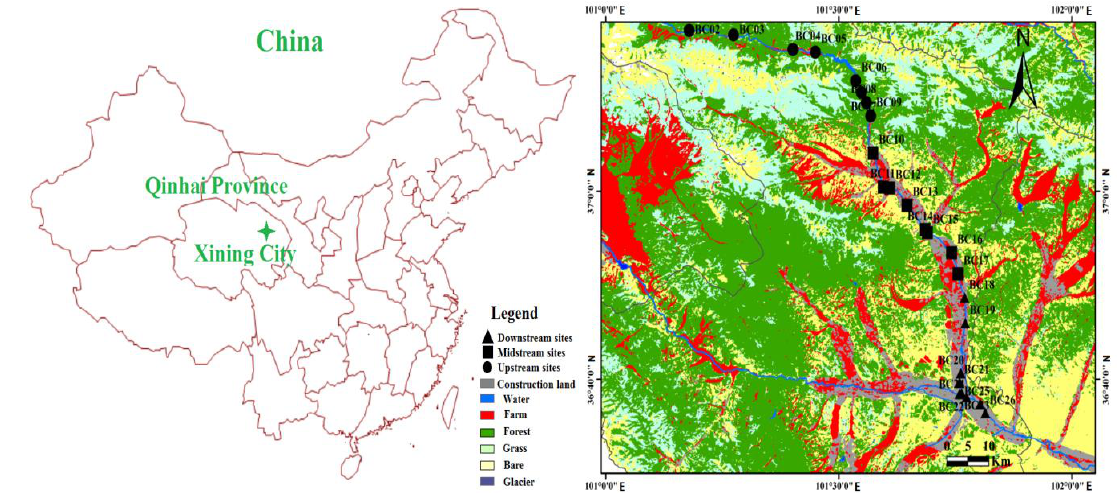
Figure 1. Water quality monitoring sites in the Beichuan River basin in China.